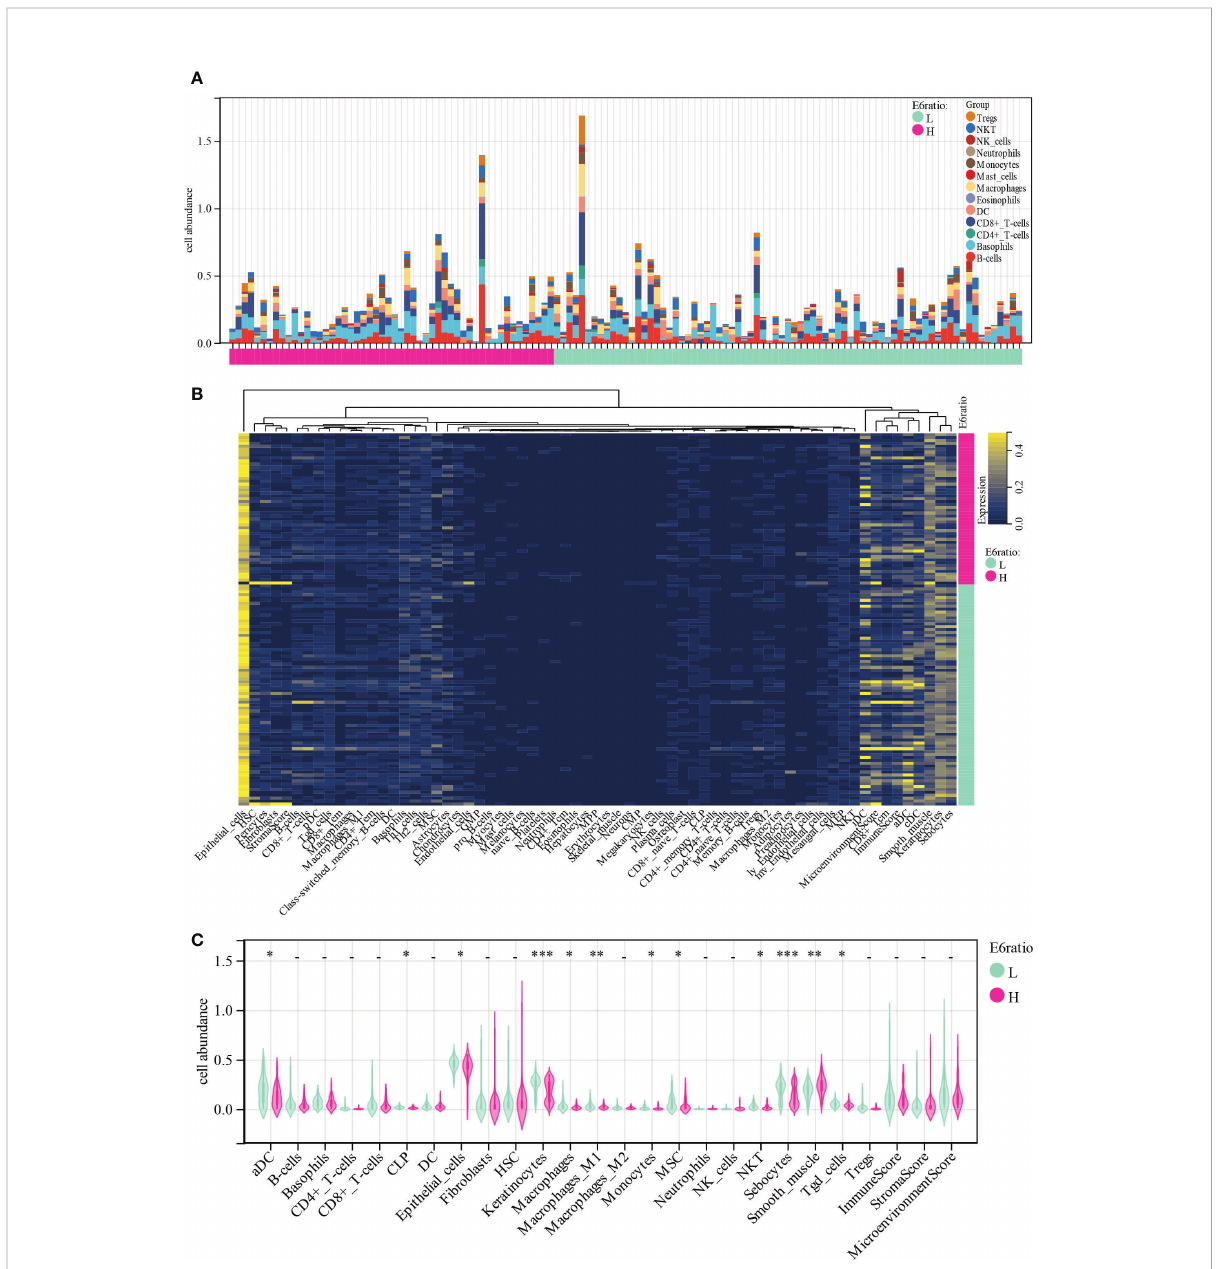
FIGURE 3 Correlations of E6ratio with immune in fi ltration level in CESC. (A) Distribution of immune cell in fi ltration in each sample. (B) Heatmap of immune cell types. (C) Violin plot of in fi ltrating immune cells in low and high E6ratio group. *, p < 0.05; **, p < 0.01; ***, p <